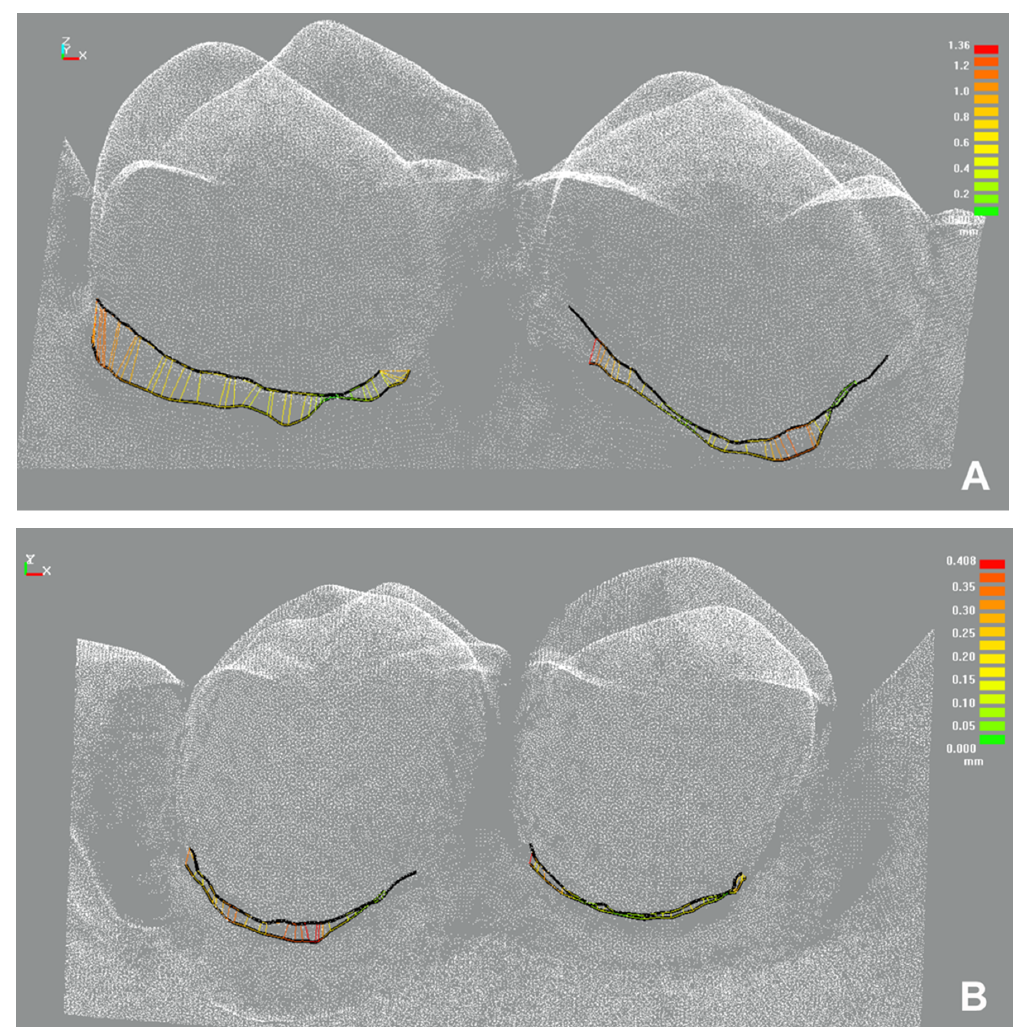
Figure 7. Curve–curve difference analysis as part of the sulcus representation analysis; view on digitized upper premolars (palatal aspect); color-coded difference images for the cord technique ( A ) and the paste technique ( B ). Table 3. Influence of the gingival condition (healthy gingiva (HG) versus artificial gingivitis (AG)) on the sulcus representation for the cord and the paste technique; *: t -Test for Dependent Samples; n.s.: not significant ( p ≥ 0.05